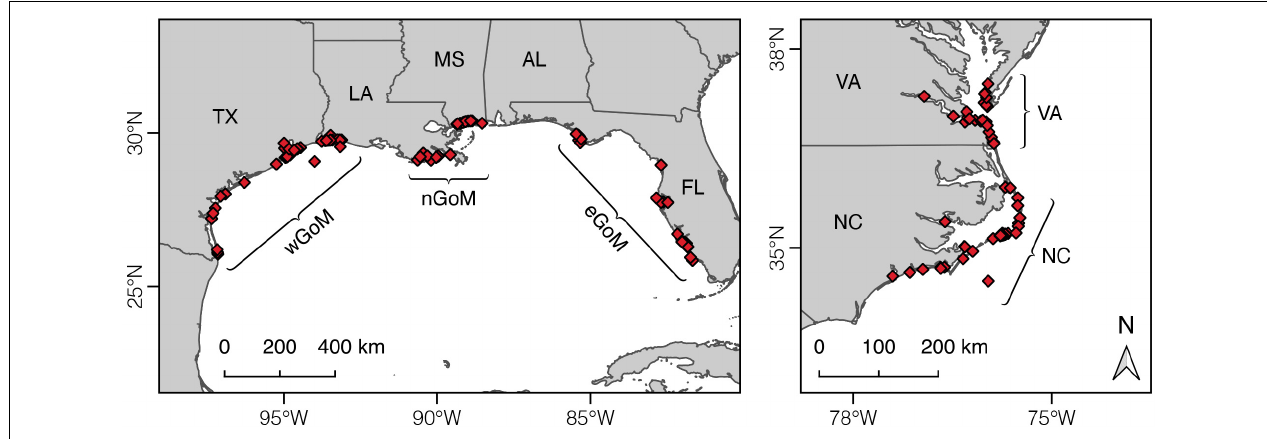
FIGURE 1 | Map of Kemp’s ridley sea turtle stranding locations for the humerus bones used in this study and geographic breakpoints used to cluster turtles and prey groups. wGoM, western Gulf of Mexico; nGoM, northern Gulf of Mexico; eGoM, eastern Gulf of Mexico; NC, North Carolina; VA, Virginia. TABLE 1 | Taxonomic and geographic summaries of Kemp’s ridley sea turtle prey stable isotope data collated from the published literature. Prey